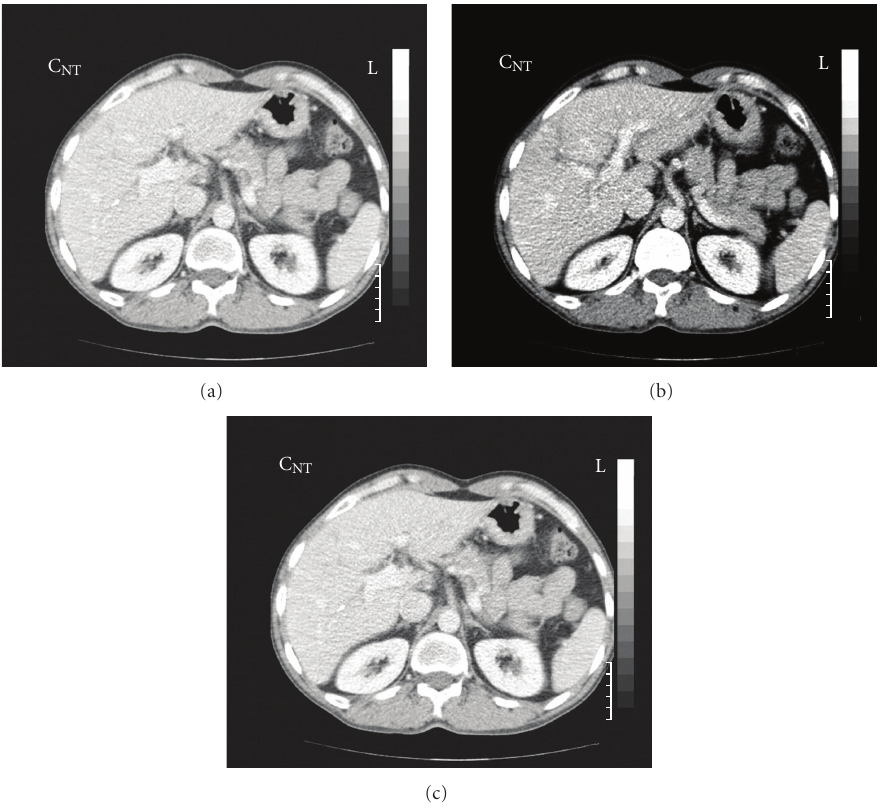
Figure 3: Regression of hepatic lesions 18 months after